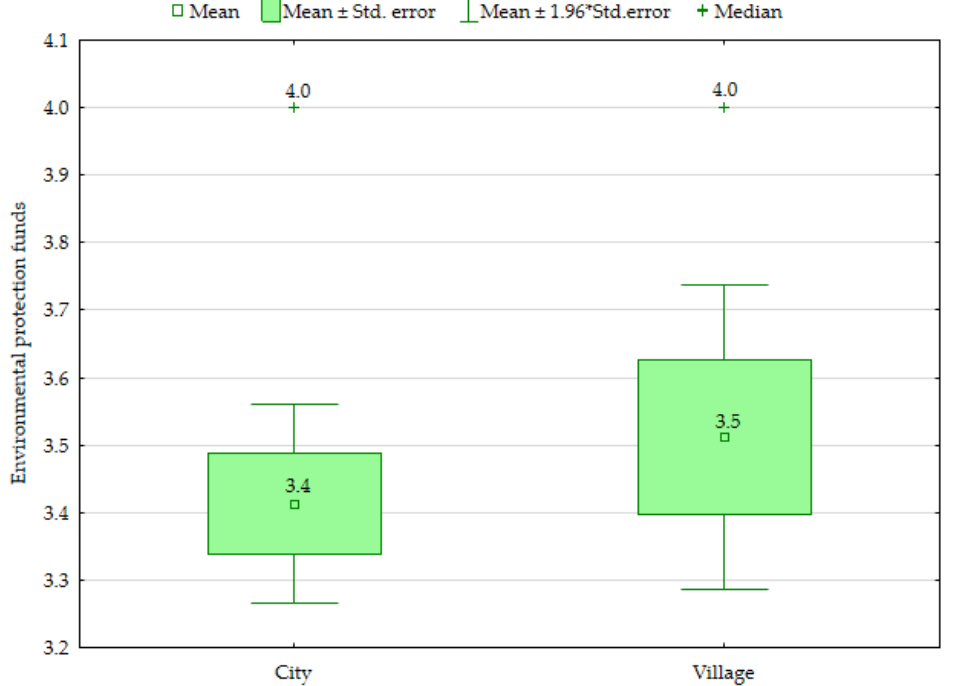
Figure 6. Place of residence and assessment of the importance of environmental protection funds. Source: Own study based on the conducted research, n = 444.